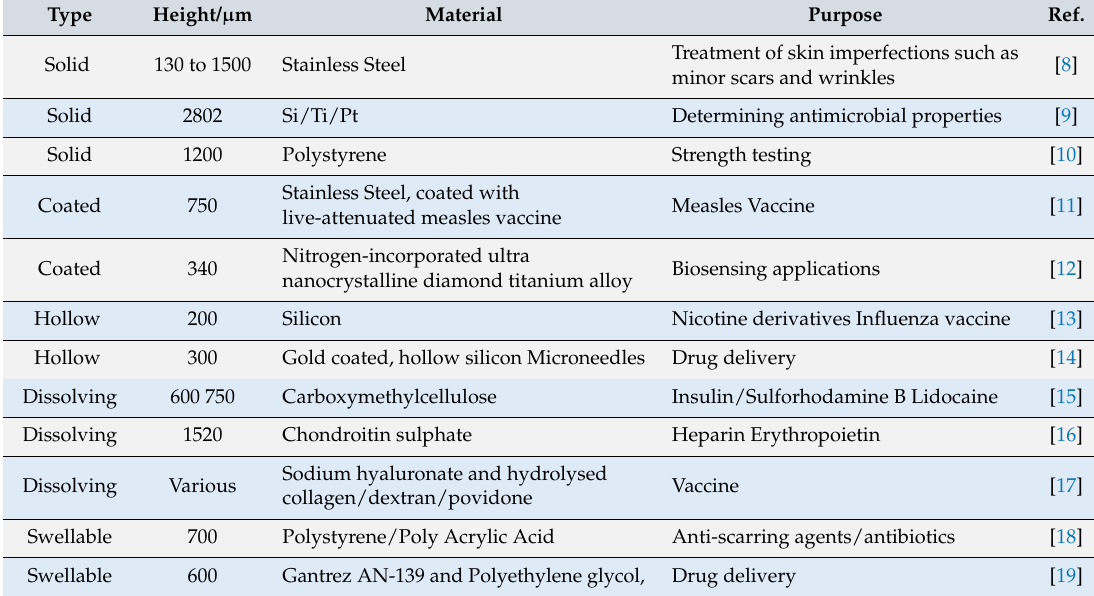
Table 1. Examples of MN